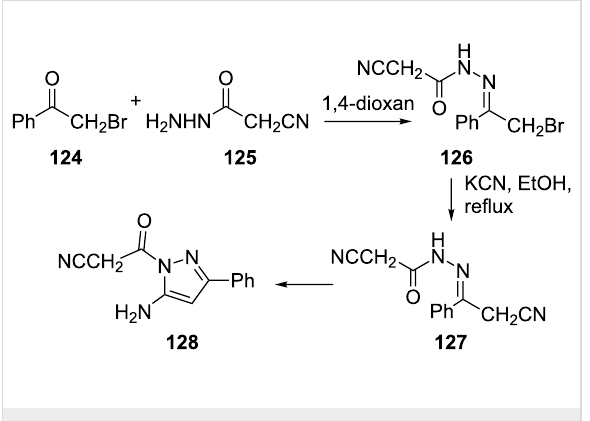
Scheme 34: Synthesis of 5-amino-1-cyanoacetyl-3-phenyl-1 H -pyra- zole.